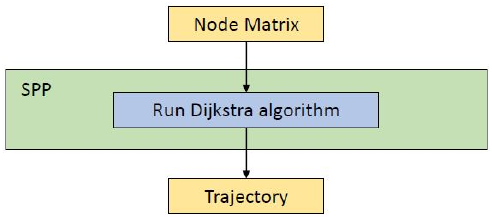
Figure 3. Flowchart of shortest-path planning (SPP) algorithm.